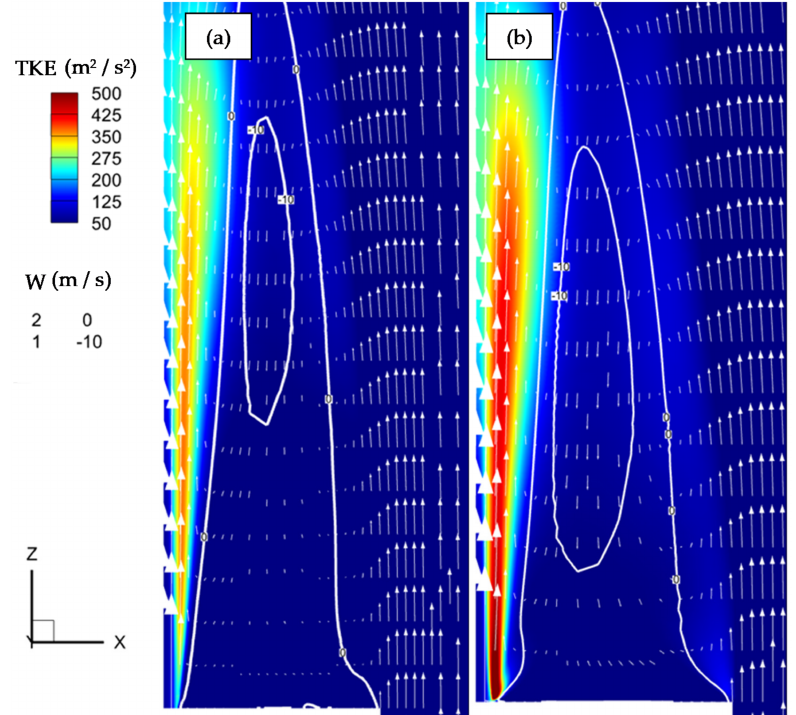
Figure 12. Turbulent kinetic energy contours with axial velocity W isolines and tangent vectors.